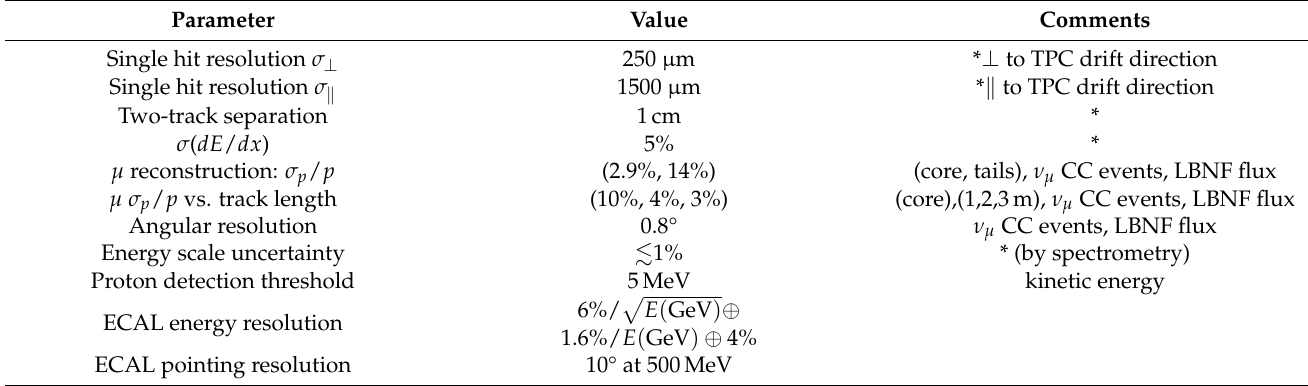
Table 15. Expected ND-GAr performance according to the studies reported in this chapter and also extrapolated from ALICE and PEP-4 (marked with an *). Here and refer to the directions perpendicular and parallel to the drift direction. ⊥ (cid:107) The momentum and angular resolutions were estimated using reconstructed ν µ CC events generated with the LBNF flux. That study is described in Section 3.4.5.1. The proton energy threshold study is described in Section 3.4.5.2. The ECAL performance is described in Section 3.4.6.